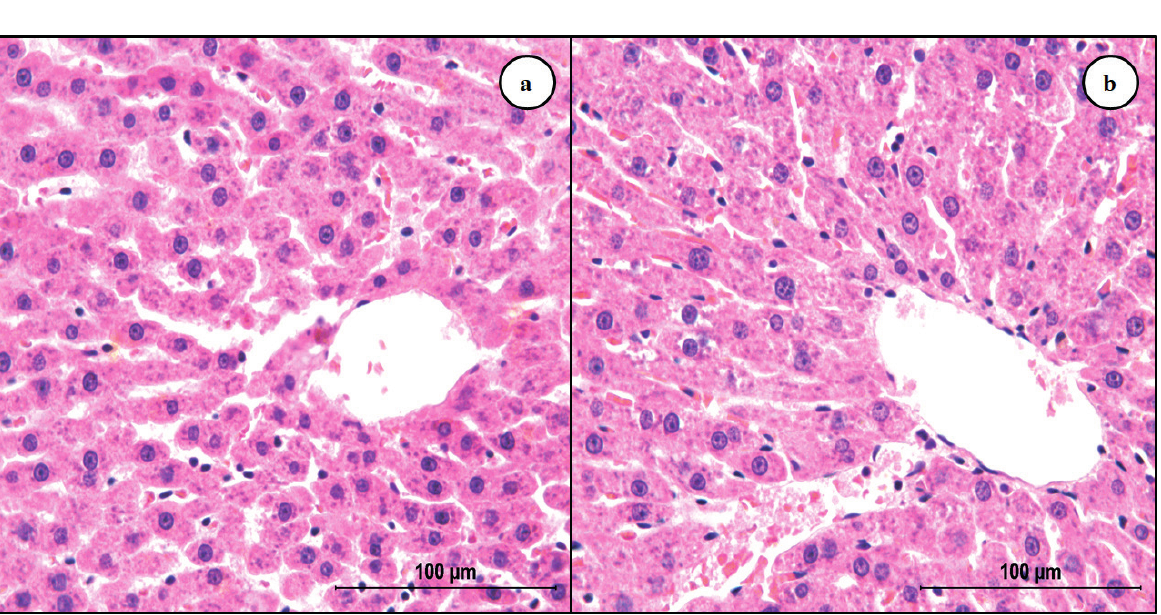
Figure 2 - Photomicrograph showing liver sections from control ( a ) and fructose ( b ) groups (H & E stain, magnification x